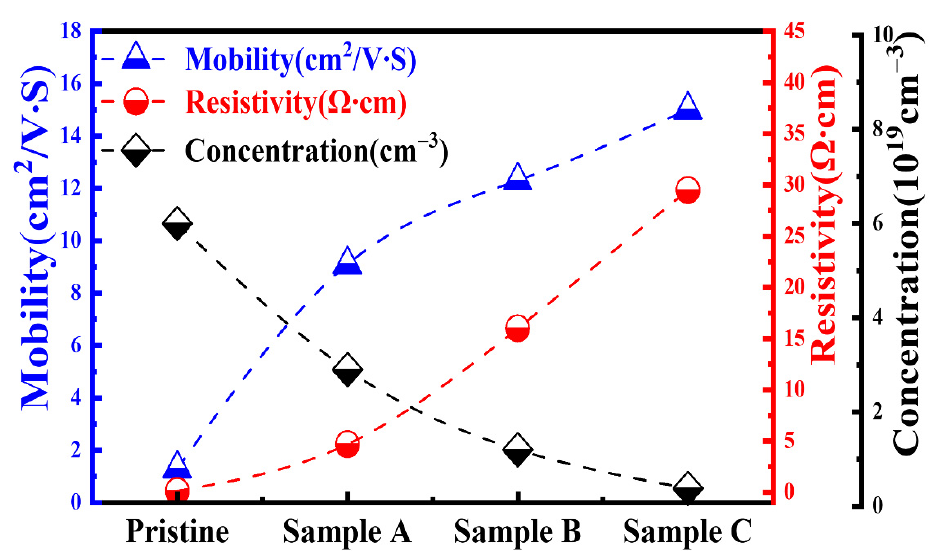
Figure 3. Hall measurement results of the pristine sample and samples A, B, and C.